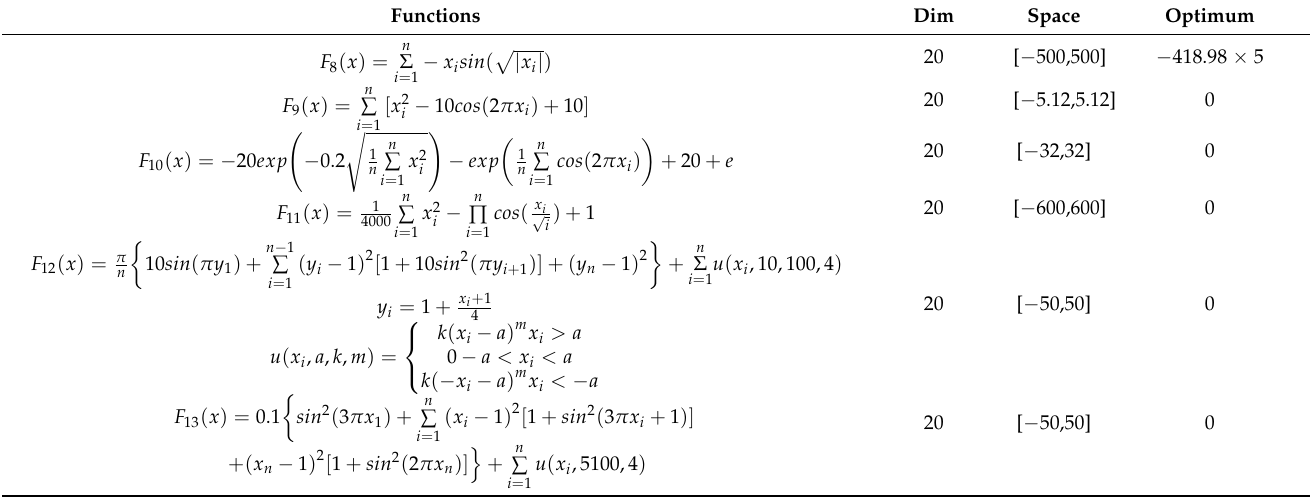
Table 2. Multimodal benchmark functions.